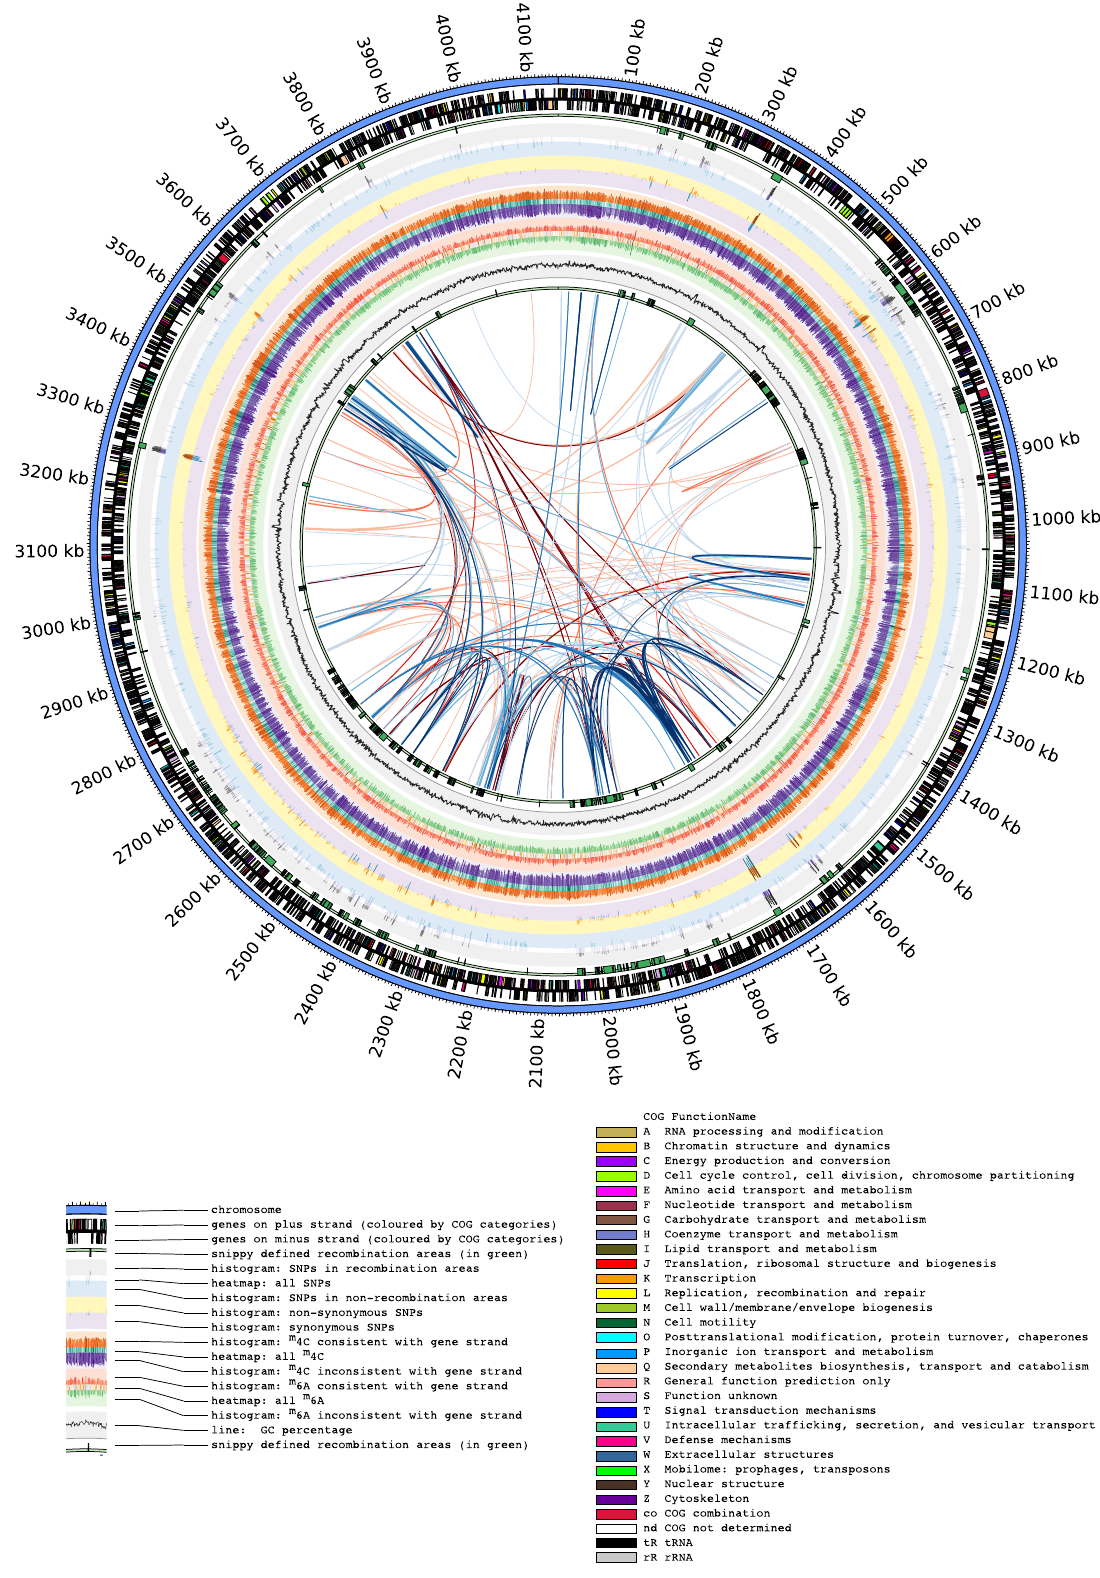
Figure 2. Circos plot of NZ L. longbeachae isolate F1157CHC. Tracks from the outside to the inside and the predicted gene functional COG category colours are denoted in the key. All data for the SNPs, methylation patterns and GC percentage are values calculated in non-overlapping 1 kb bins. The data for the SNPs and methylation patterns are shown in a log10 scale, and the histograms are also coloured so that larger values are in darker colours. In the centre of the plot are the results from the Reputer analysis, with palindromic repeats in red and forward repeats in blue. The repeats are darker in colour with a smaller Hamming distance between the